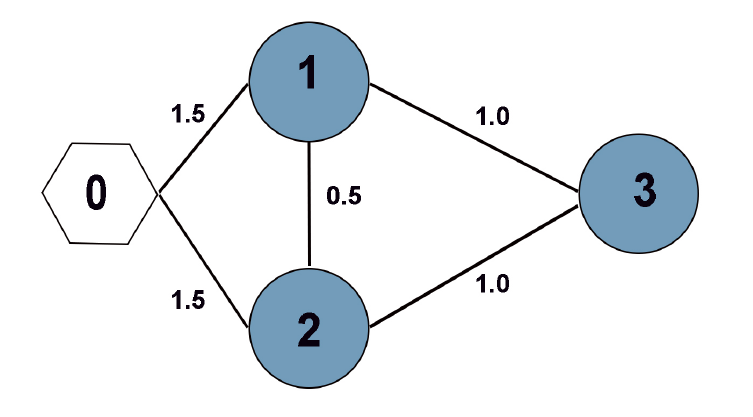
Figure 2. Interaction topology between